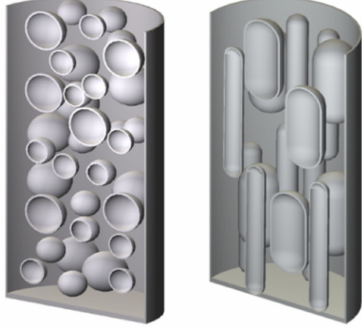
Figure 1. Schematic diagram of